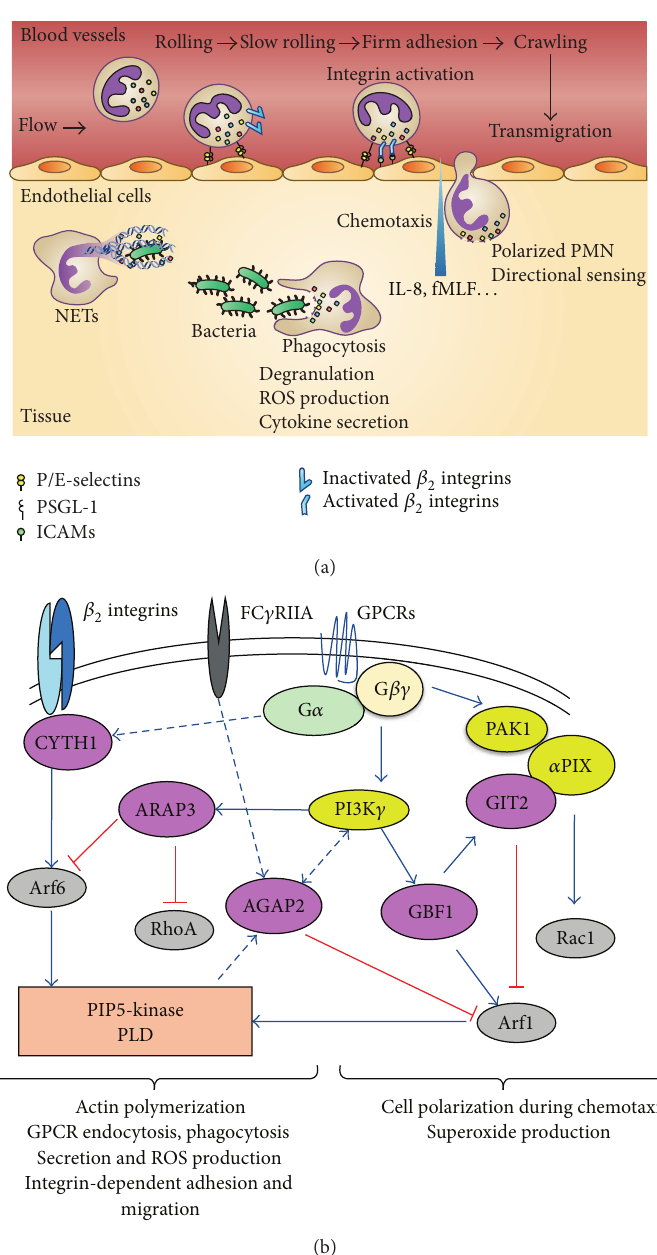
Figure 1: Main steps in PMN transmigration and regulation of PMN functional responses by Arfs and their regulators. (a) Schematic representation of PMN extravasation in infectious and noninfectious diseases. The first contact with endothelial cells is mediated by engagement of selectins with their counterreceptor P-selectin glycoprotein ligand-1 (PSGL-1) which results in capture and rolling of PMNs. Activation of PMNs by selectins and the different inflammatory signals like chemokines while rolling induces activation of the 𝛽 2 integrins (LFA-1 and Mac-1) and slow rolling. Binding of activated 𝛽 2 integrins to their counterreceptors ICAMs on endothelial cells induces PMN arrest due to firm adhesion and Mac-1-dependent crawling. Polarization of PMNs toward the chemoattractant source (i.e., cytoskeletal rearrangement, recruitment of regulators of Arfs, and activation of PI3K 𝛾 , Arf1, and NADPH oxidase at the leading edge) initiates directional sensing and transmigration across the vascular endothelium. PMNs are guided by the gradient of chemoattractant factors and after arriving at the site of infection or tissue injury, the cells initiate phagocytosis or NETosis to kill pathogens and remove cellular debris. PMN granules are schematically represented by colored circles. (b) Signalling pathways downstream of GPCRs, Fc 𝛾 receptor IIA (Fc 𝛾 RIIA), and 𝛽 2 integrins by which Arfs and their regulators are thought to regulate PMN functional responses are presented schematically. Green arrows indicate direct activation either through lipid-protein or through protein-protein interactions, and negative feedback mechanisms are highlighted in red. Where direct interactions have not been established and/or the signalling mechanisms are unclear, lines are dotted. Cross talk between Arf and Rho family GTPases mediated by ARAP3 and the p21 protein- (Cdc42/Rac-) activated kinase 1 (PAK1)/PAK-interacting Exchange Factor alpha ( 𝛼 PIX) signalling complex is also